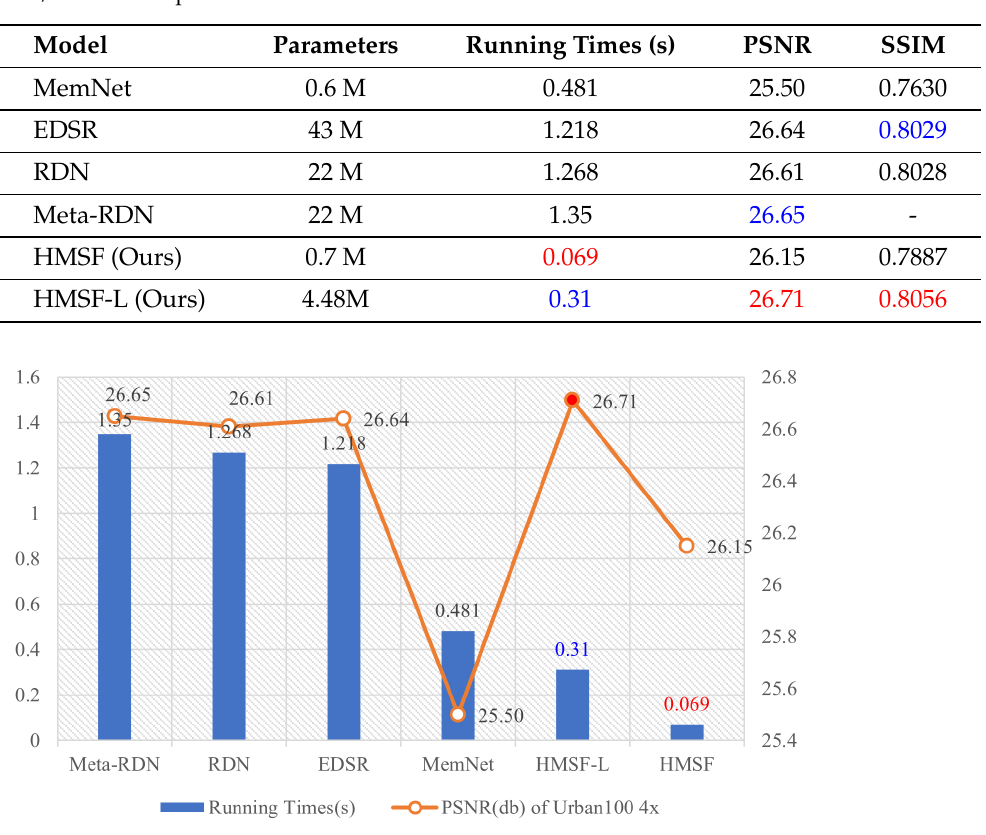
Table 12. Comparison of average running time on Urban100 for 4 × . Red/blue text means the best/second-best performance.